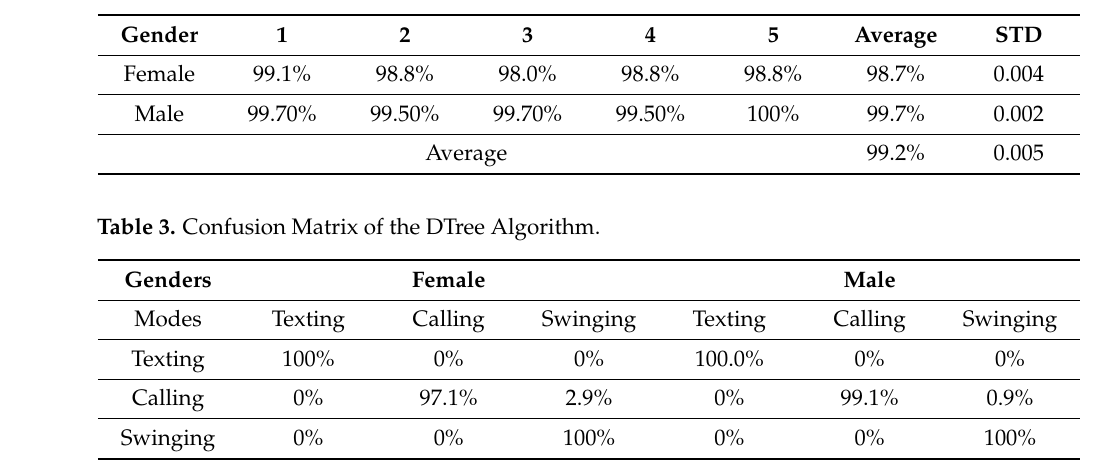
Table 2. The recognition accuracy of DTree algorithms based on the 5-fold cross-validation.